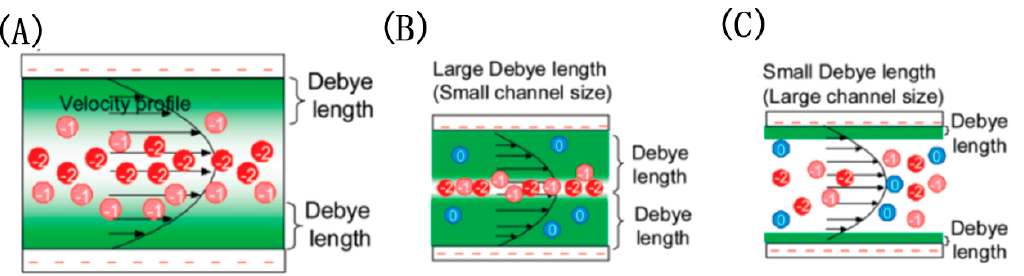
Figure 8. Separation mechanism of extended nanospace channel. ( A ) Double electric layers built up when flow passed through the nanospace channel. ( B ) Large Debye length results in small channel size, all the analytes locate at the center of the profile and the separation cannot happen. ( C ) Small Debye length results in large channel size and the analytes spread in the nanospace channel. Adapted from Kato et al. [50]. Copyright 2010 American Chemical Society, 2010.